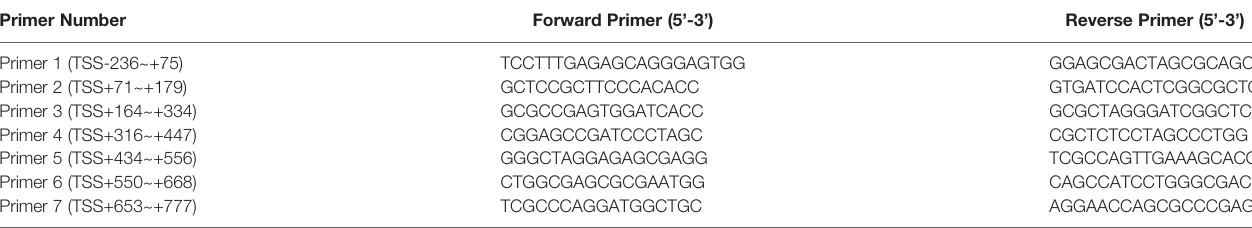
TABLE 3 | List of primers used for ChIP-qPCR in HPASMCs for BMP2 gene. Primer Number Forward Primer (5 ’ -3 ’